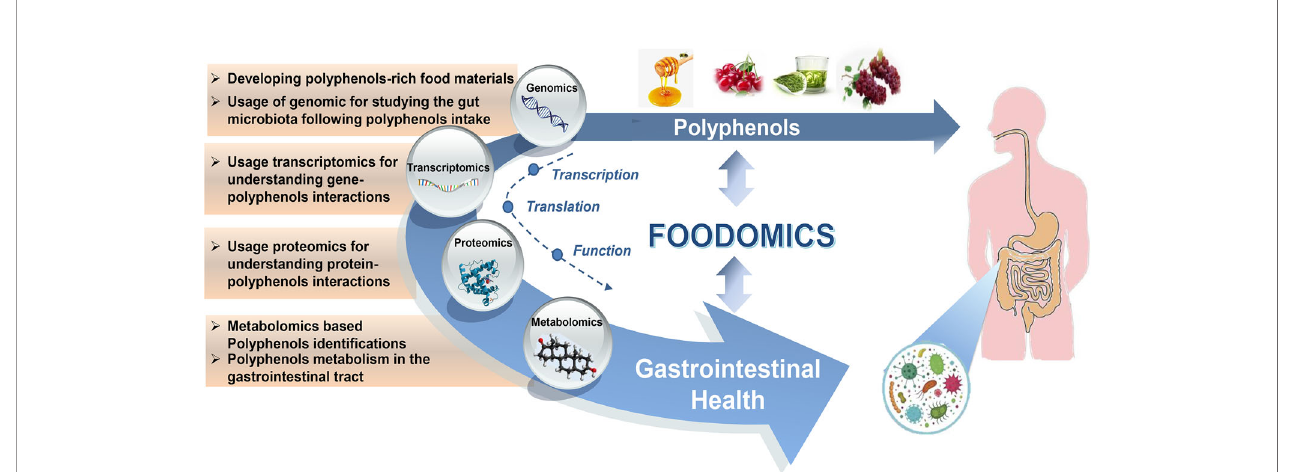
FIGURE 1 | Foodomics helps us understand the interplay between polyphenols, gut microbiota, and host health. Foodomics applies multiple high-throughput omics technologies to provide novel insights into gene transcription, protein expression, and dietary polyphenols metabolism that interact with gut microbiota and host